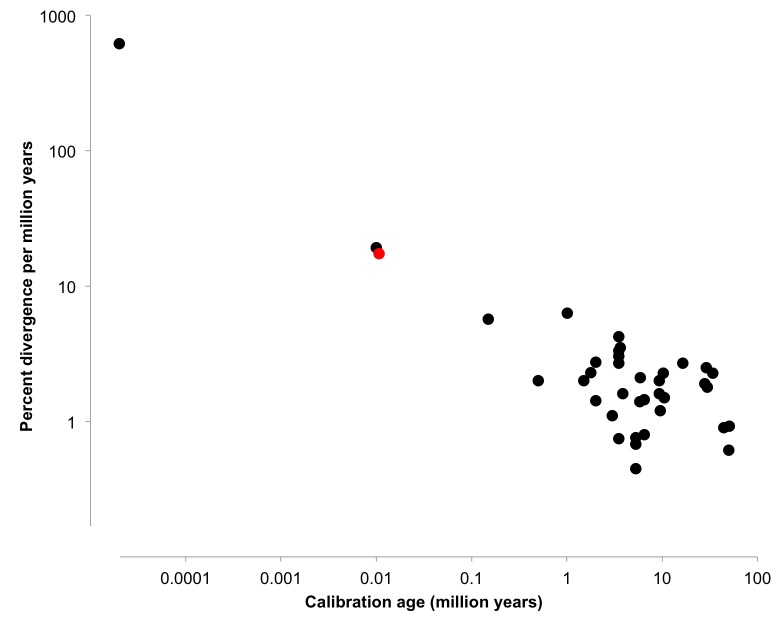
The black data points were obtained directly from 20,21. The red point represents the mutation rate estimate from this study. Note both axes are in log scale.